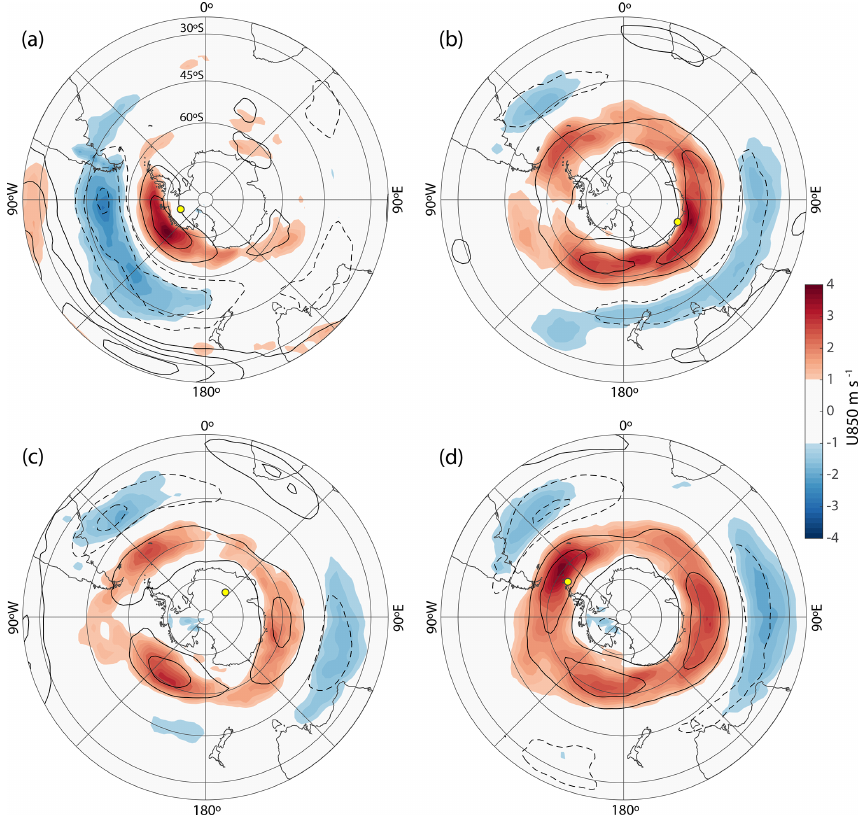
Figure 4. Zonal wind speed at 850hPa (color shading, see scale bar) and 200hPa (2ms − 1 contours) regressed onto surface synoptic activity (cid:56) at the Antarctic ice core sites of (a) WAIS Divide, (b) Law Dome (DE08, DE08-OH, and DSSW20K), (c) Dome Fuji, and (d) James Ross Island. Yellow dots mark the ice core